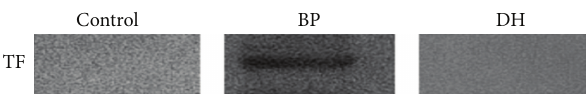
Figure 5: Mean value of optical densities (OD) of control and DH background and BP protein. Asterisks indicate a significance difference ( ∗ 𝑝 < 0.05 ) (mean ± SEM), TF: tissue factor; DH: Duhring disease; BP: bullous